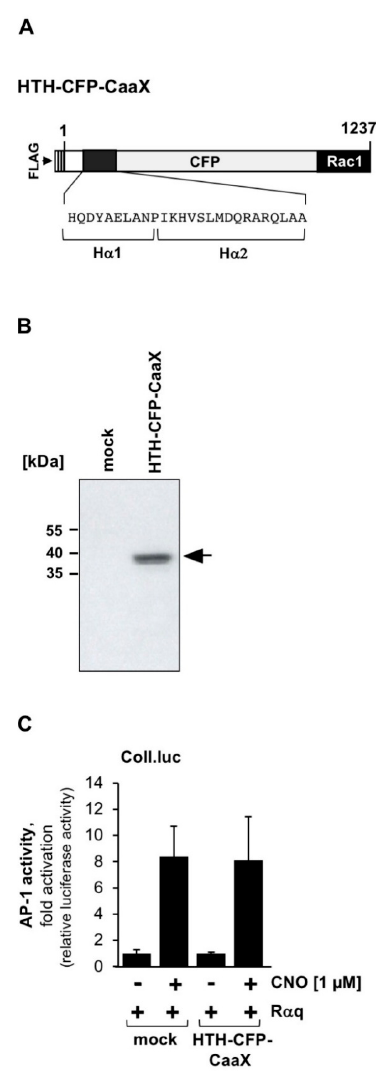
Figure 3. A fusion protein containing the helix-turn-helix (H α 1—H α 2) motif of PLC β 3 does not function as a dominant negative of G α q-coupled receptor signaling. ( A ) Modular structure of HTH-